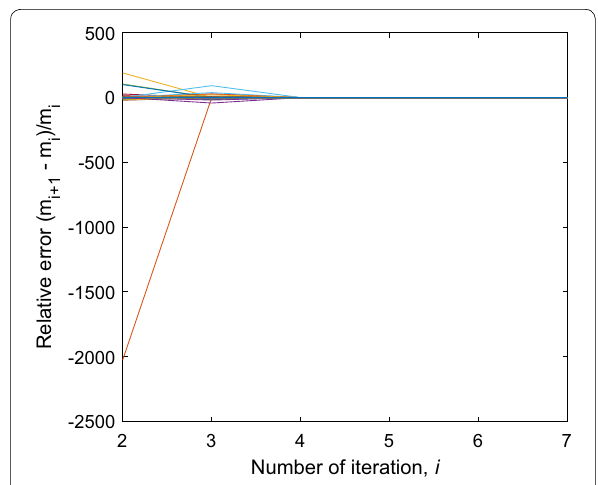
Fig. 4 Relative difference between consecutive model coefficients as a function of the number of iterations for one of the 1000 ensembles for the DGRF parent